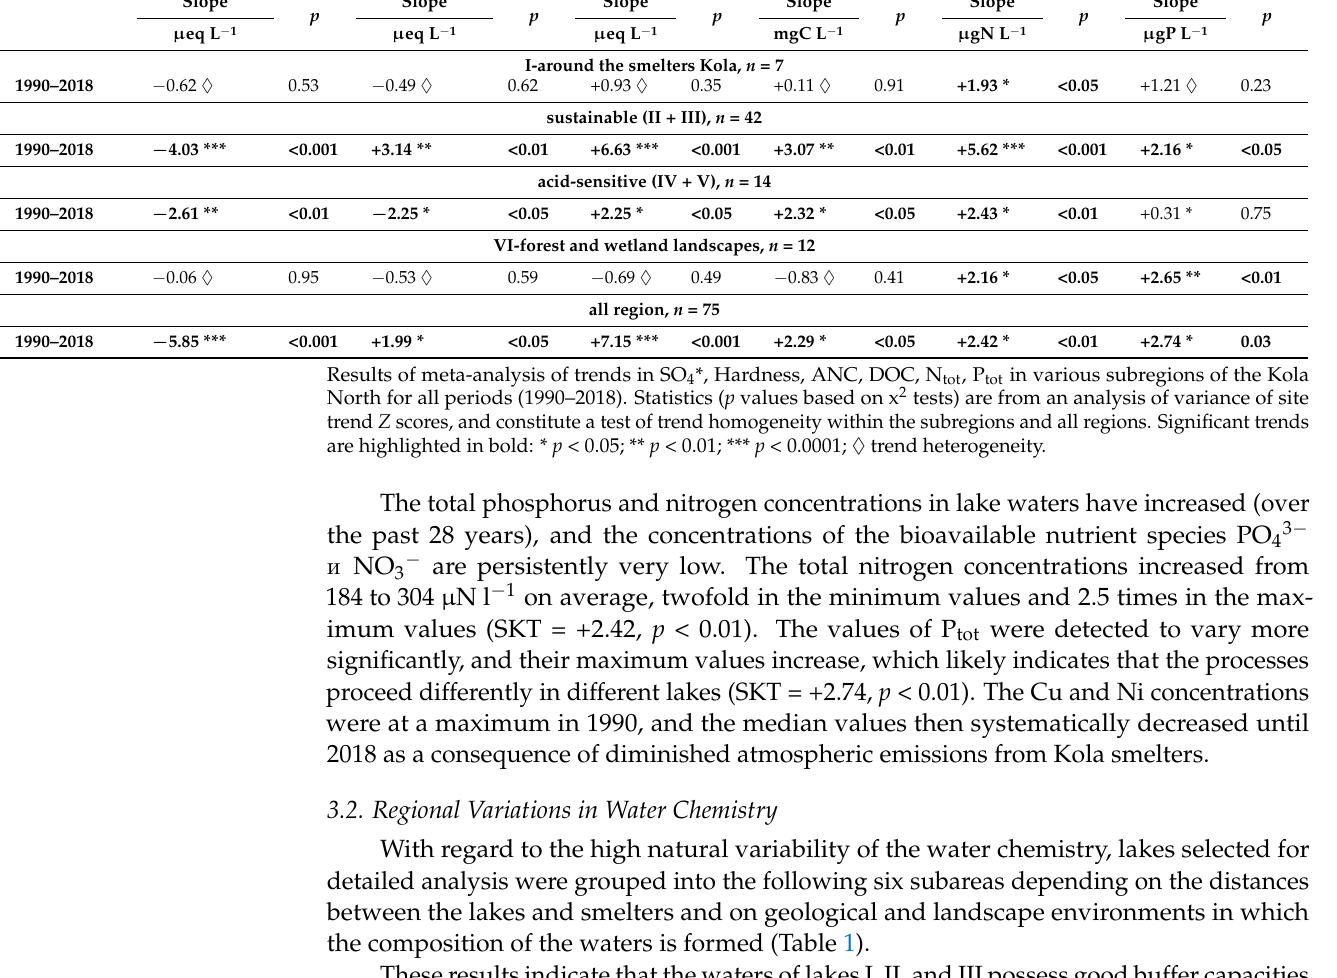
Table 3. Regional trend Mann–Kendall tests (SKT) of water chemistry parameters of the water bodies for a 28-year period (1990–2018) in various subregions of the Kola North. SO 4 * Trend Hardness (Ca 2+ + Mg 2+ ) Trend ANC Trend DOC Trend N tot Trend P tot